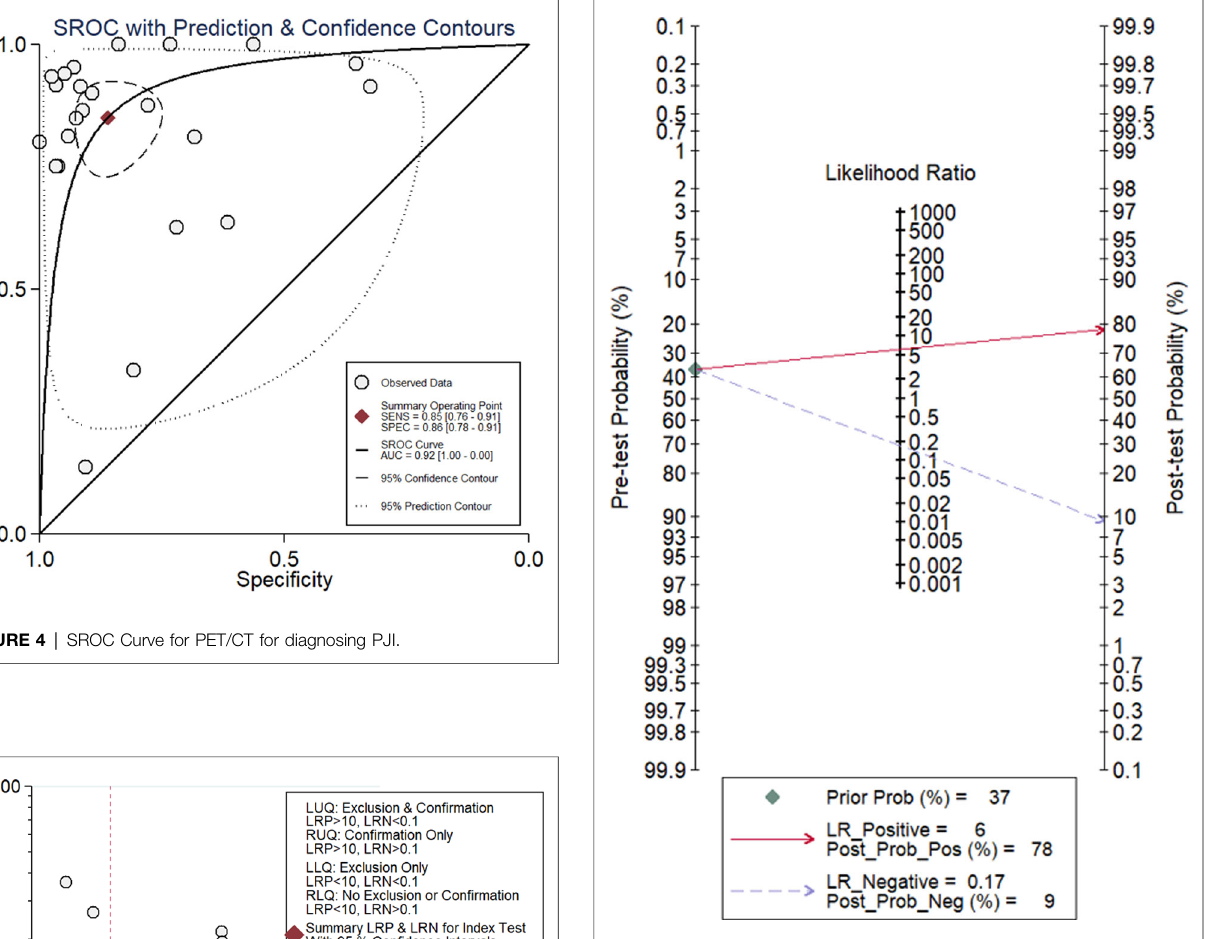
FIGURE 6 | Fagan nomogram evaluating the overall value of PET/CT for PJI diagnosis.